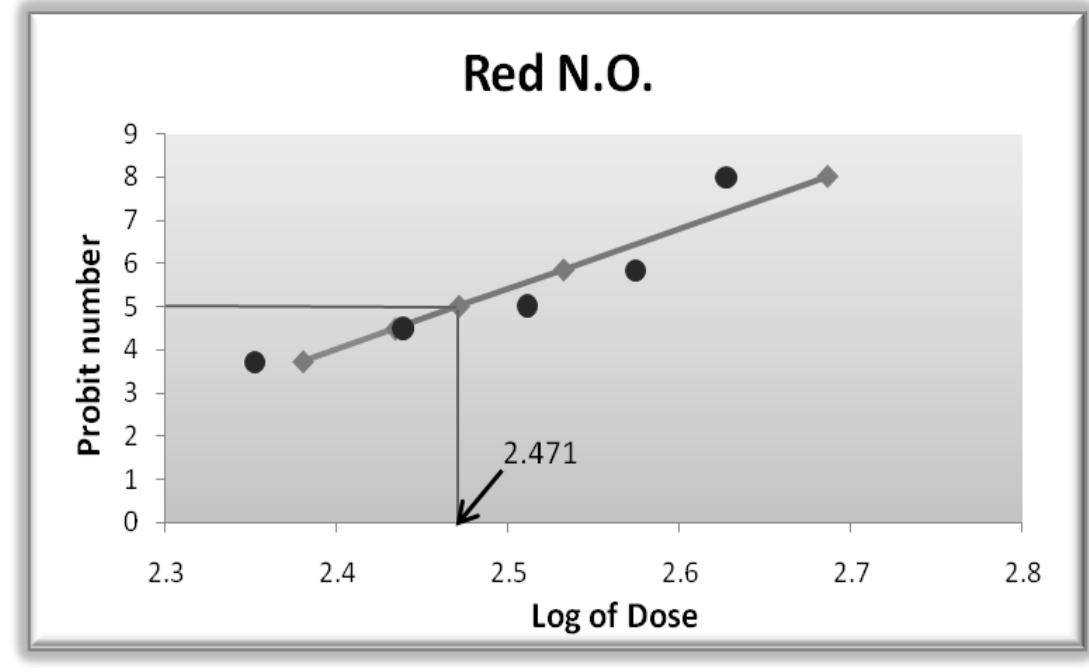
Fig 1:- Estimation log dose-probit curve for hexane extract of the RFG of N.oleander after fitting LD